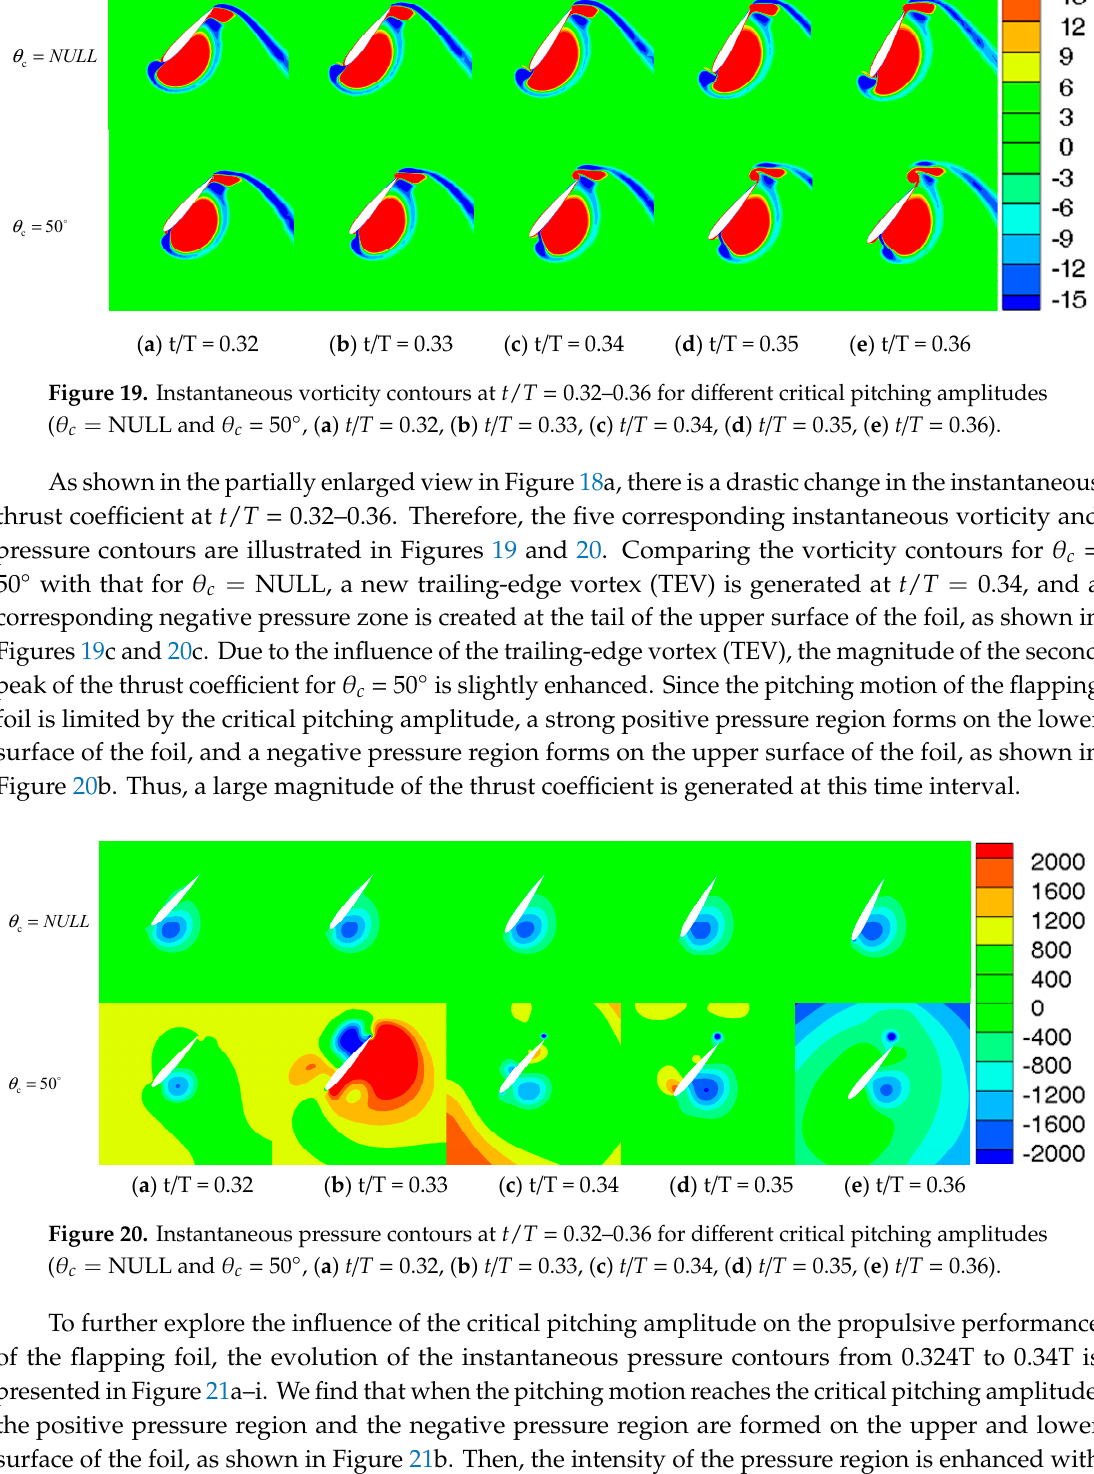
Figure 20. Instantaneous pressure contours at t/T = 0.32 − 0.36 for different critical pitching amplitudes ( θ c = NULL and θ c = 50 ◦ , ( a ) t / T = 0.32, ( b ) t / T = 0.33, ( c ) t / T = 0.34, ( d ) t / T = 0.35, ( e ) t / T = 0.36).